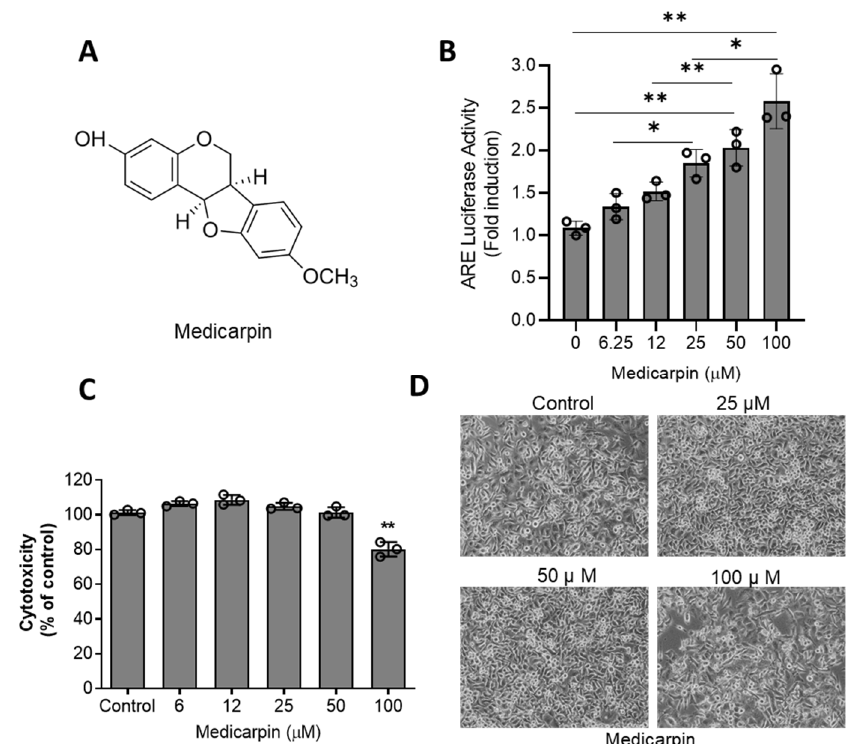
Figure 1. Medicarpin increases the ARE luciferase activity in HeLa cells. ( A ). Chemical structure of medicarpin. ( B ). The ARE-luciferase assay was performed in HeLa cells after treatment with indicated concentrations of medicarpin for 6 h. ( C ). The cytotoxic effect was measured by an MTT assay after treatment with different medicarpin concentrations of for 24 h. ( D ). The representative images of the HeLa cells were pictured after treatment with indicated concentrations of medicarpin for 24 h. The cell images were taken at the same magnification. Experiments were performed in triplicate and repeated three times with similar results. * p < 0.05; ** p <